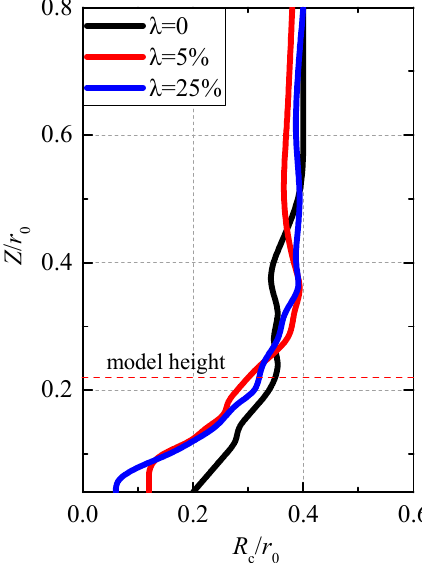
Figure 6. Core radius variation with height ( S = 0.35).